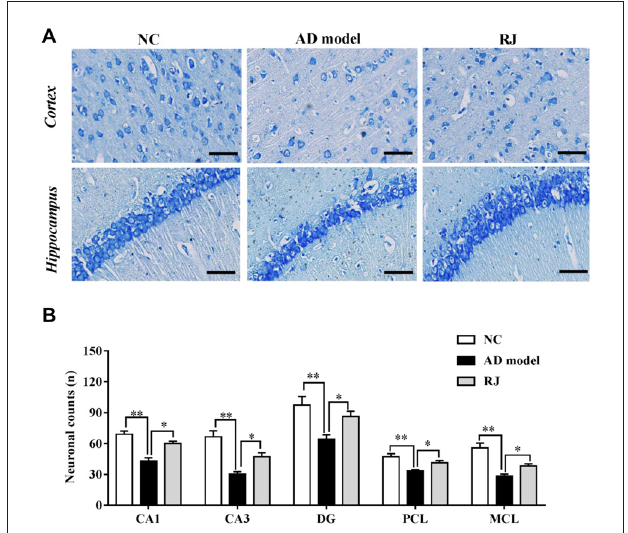
FIGURE 4 | RJ rescued neuronal loss in the brain of AD rabbits. (A) Nissl-staining images in the frontal cortex and the hippocampus of the AD model, RJ and NC group. Scale bar = 50 µ m. (B) Neuronal counts per view (40 × ) in the hippocampal CA1, CA3, DG regions and cortical pyramidal cellular layer (PCL) and multiform cellular layers (MCL) areas among the three groups, n = 6 rabbits per group. Data are presented as mean ± SEM. ANOVA with post hoc Tukey’s test was used. ∗ P < 0.05, ∗∗ P < 0.01 vs. the AD model group.